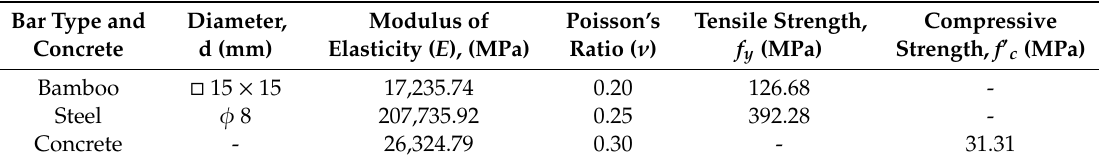
Table 1. Material properties of reinforcing and concrete.